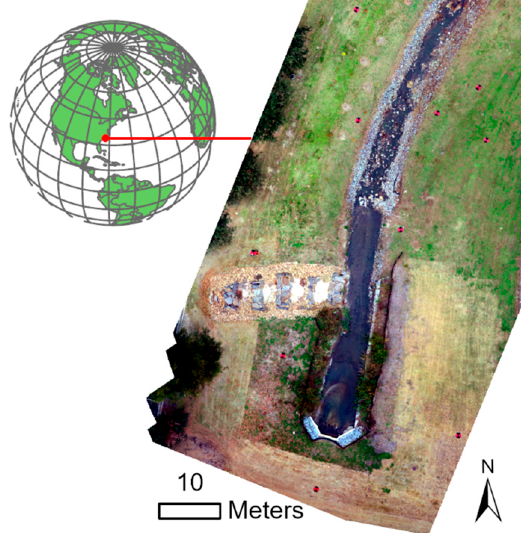
Figure 1. The study area of a channelized stream located in eastern North Carolina, USA.